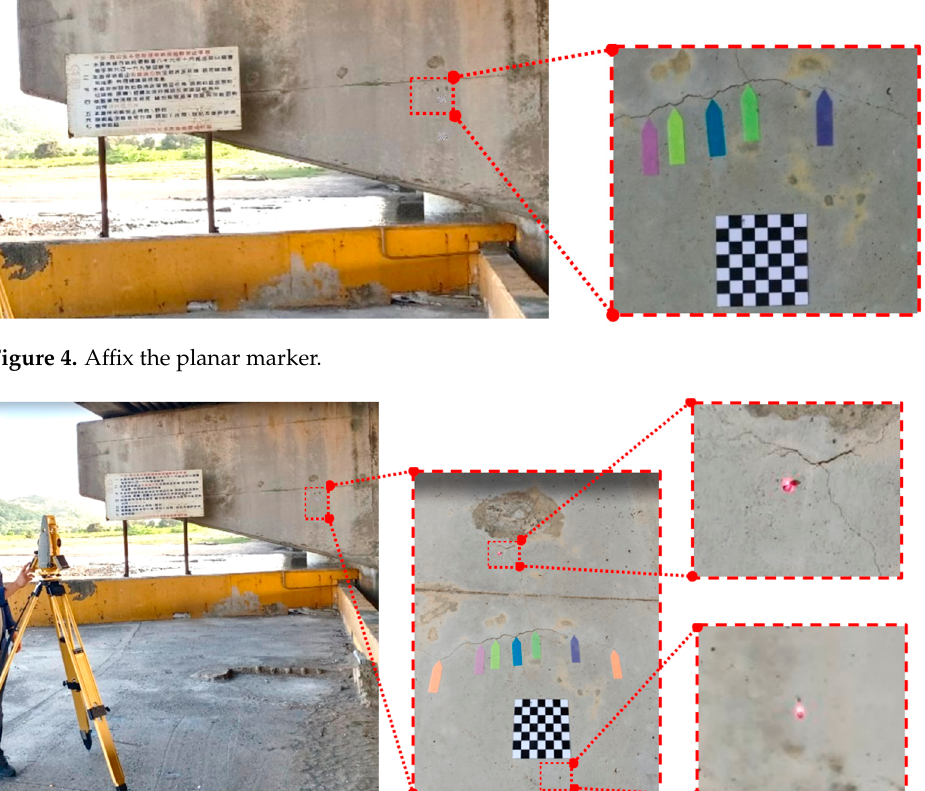
Figure 5. Total station measurement feature points.